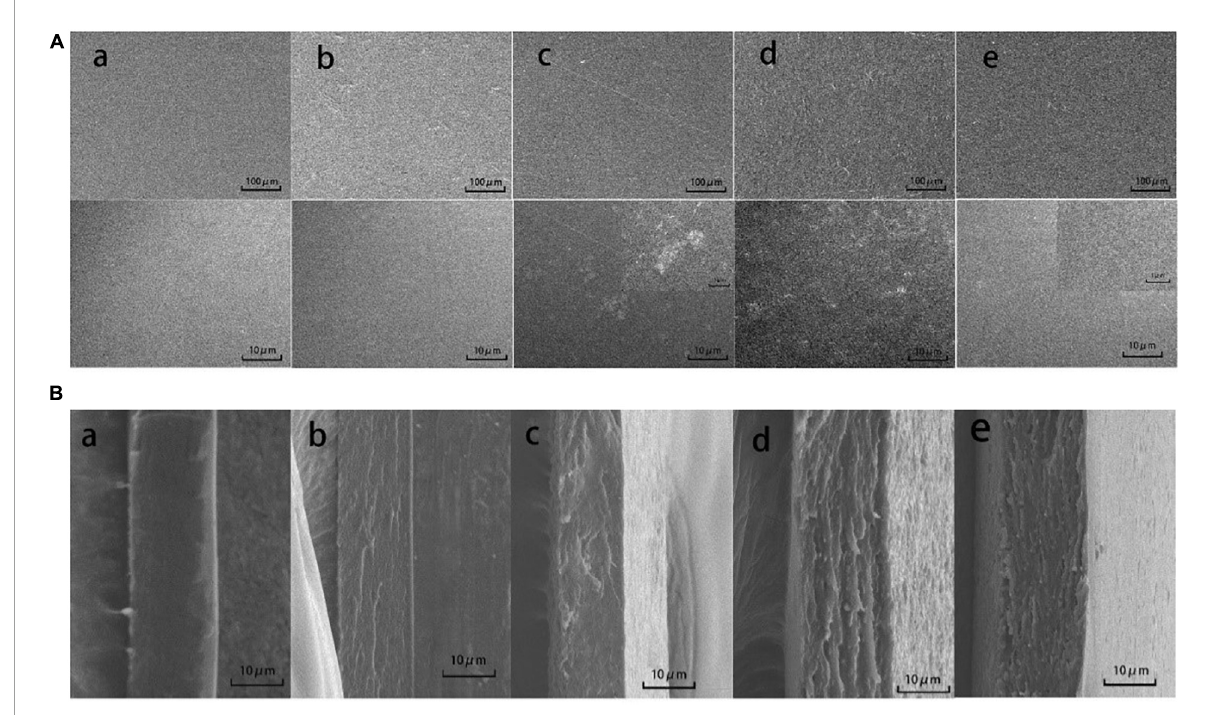
FIGURE3 Scanning electron microscopy photographs of the surfaces (A) and cross-sections (B) of CS (a), CS/WPI (b), CS/WPI/WPEO (c), CS/WPI/TiO 2 (d), and CS/WPI/WPEO/TiO 2 (e)